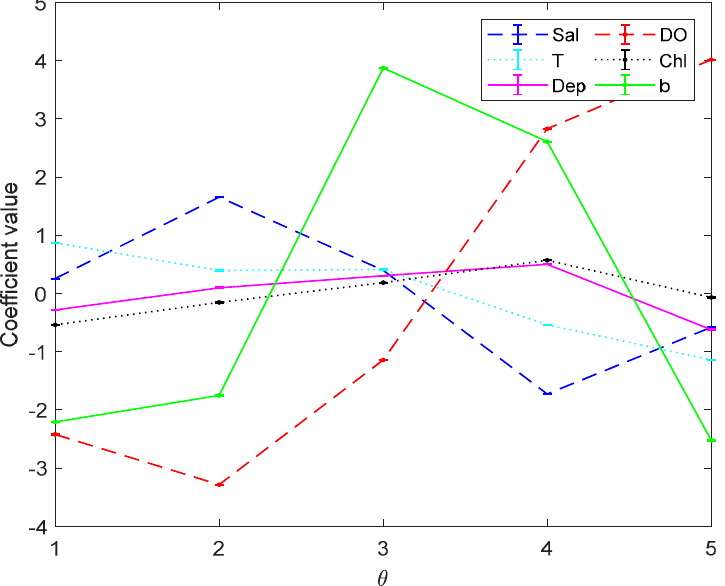
Figure 4. Classifiers by softmax regression after data preprocessing.